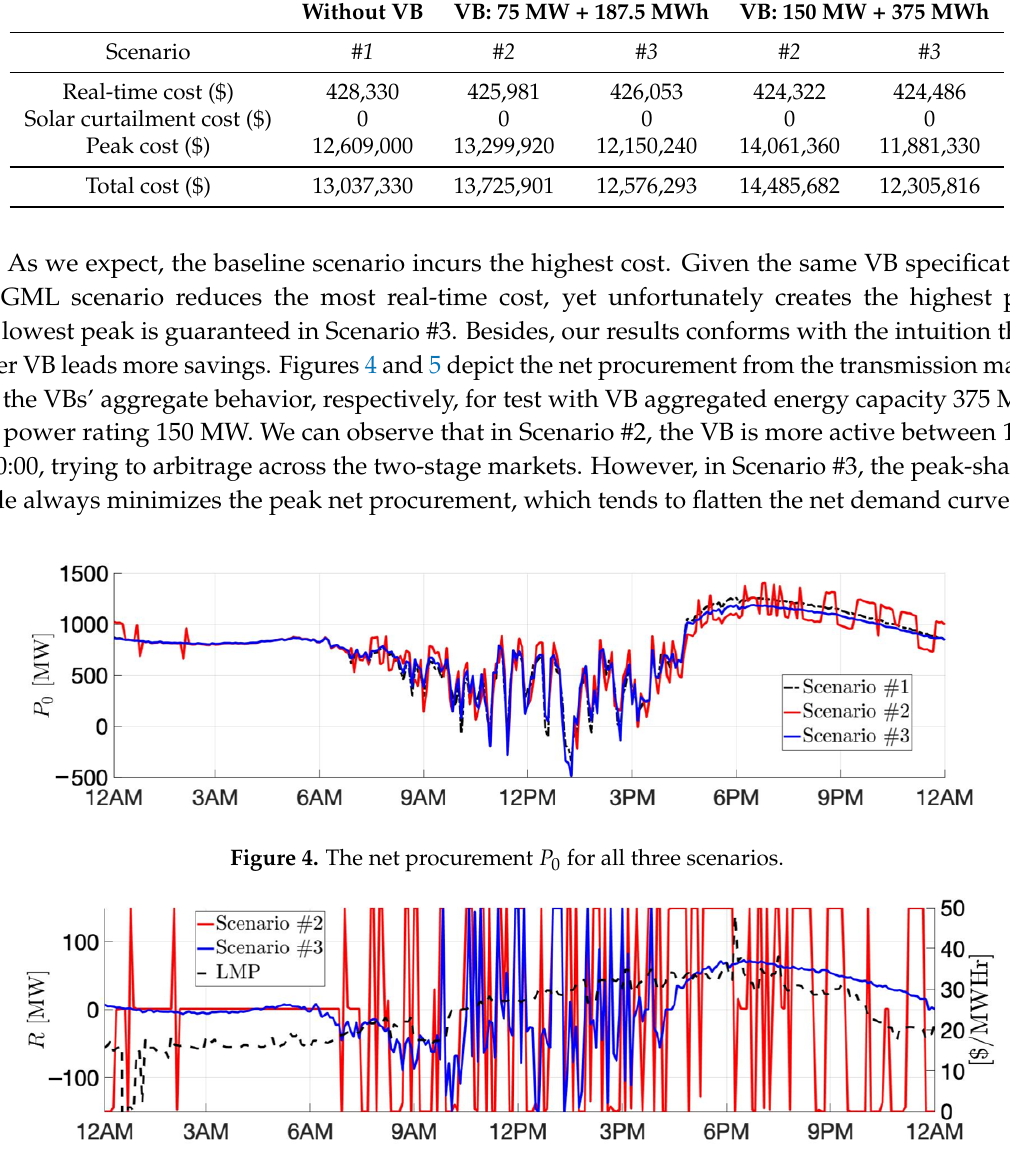
Figure 5. The aggregate virtual battery (VB) discharge with the real-time price. When the price is high, the VB tends to discharge to avoid a high real-time cost, e.g.,